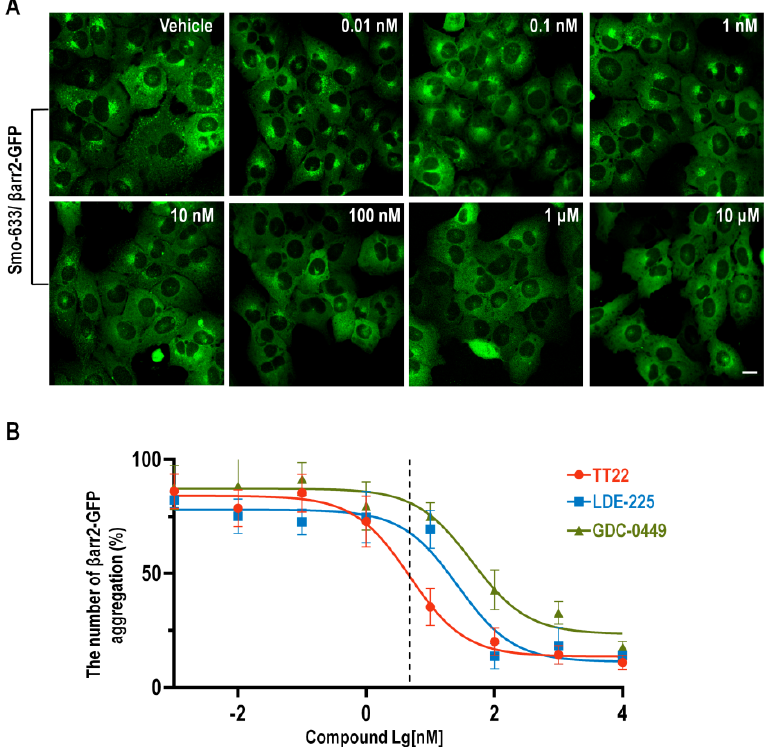
Figure 2. The intracellular aggregation of β arr2-GFP was inhibited by TT22. ( A ) The U2OS cells stably expressing β arr2-GFP and Smo-633 were treated with the indicated concentration of TT22 (10 − 12 –10 − 5 M) for 24 h at 37 ◦ C. ( B ) The percentage of the number of β arr2-GFP aggregation was quantitated. The scale bar is 20 µ